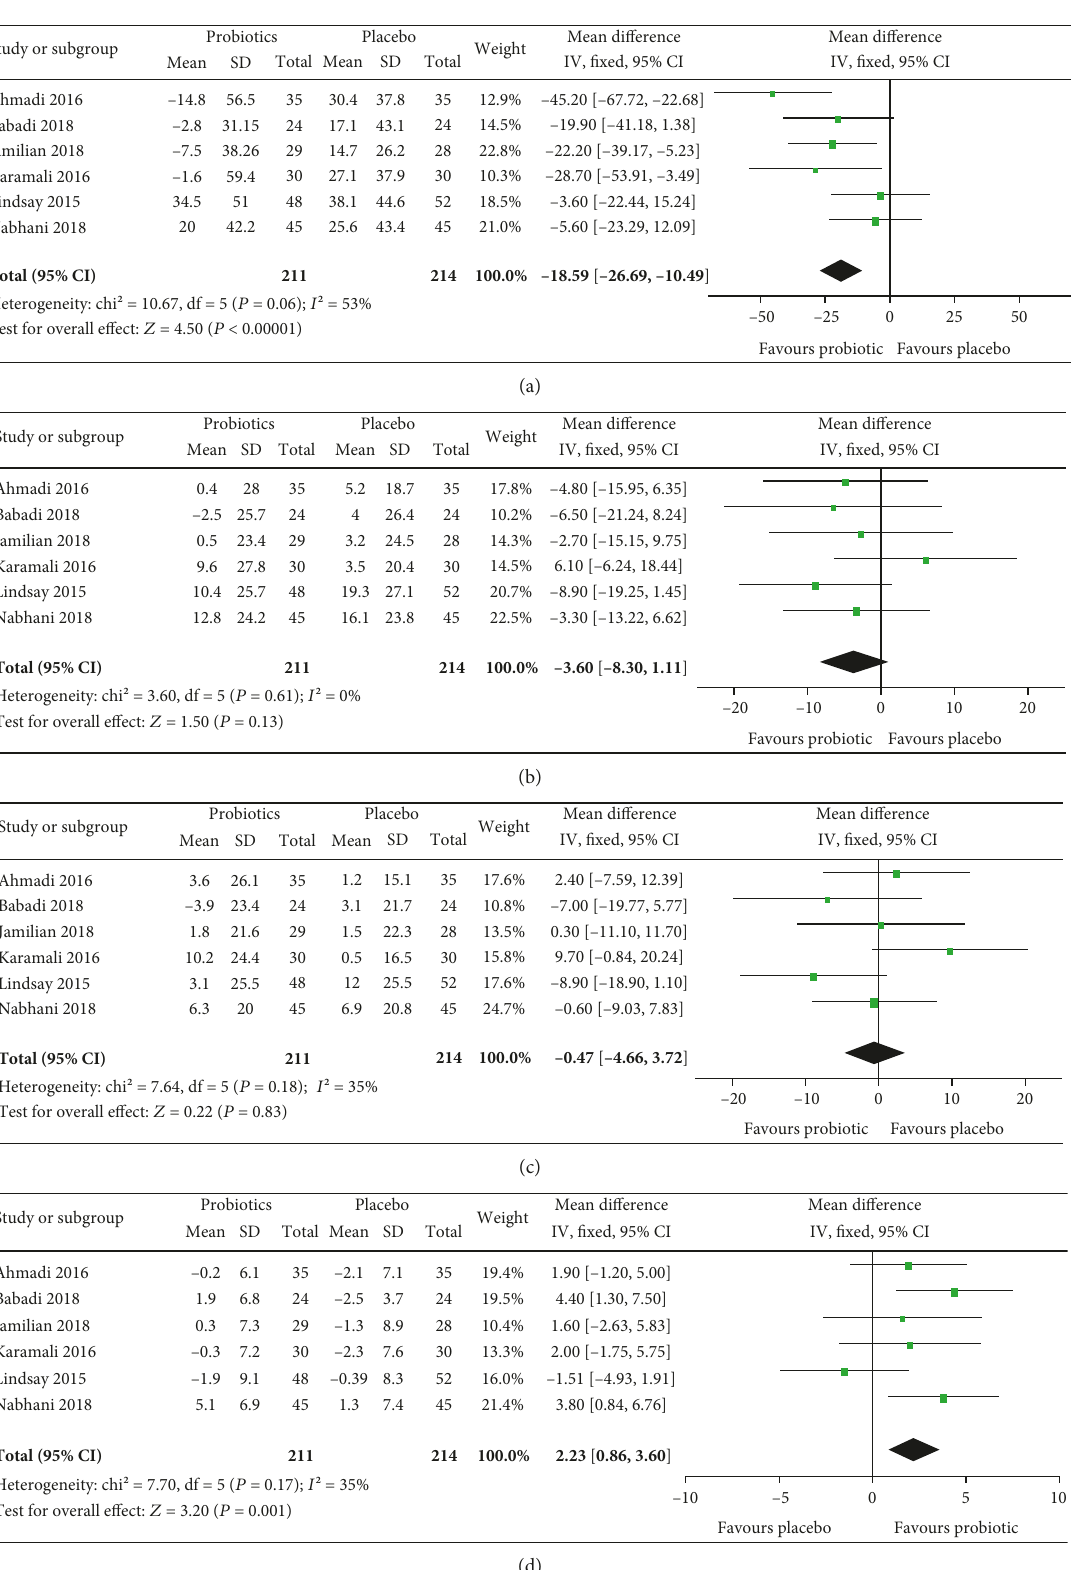
Heterogeneity: chi² = 7.70, df = 5 ( P = 0.17); I ² = 35% Test for overall effect: Z = 3.20 ( P = 0.001)